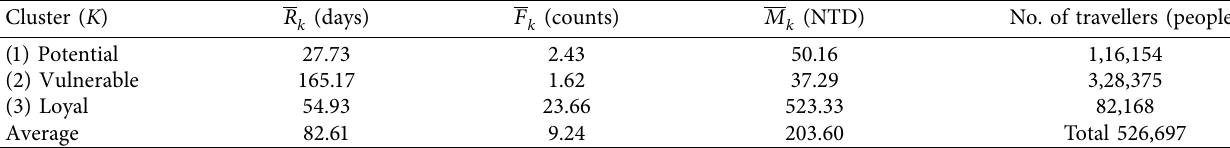
Table 6: Clustering results by K -means for 2018.